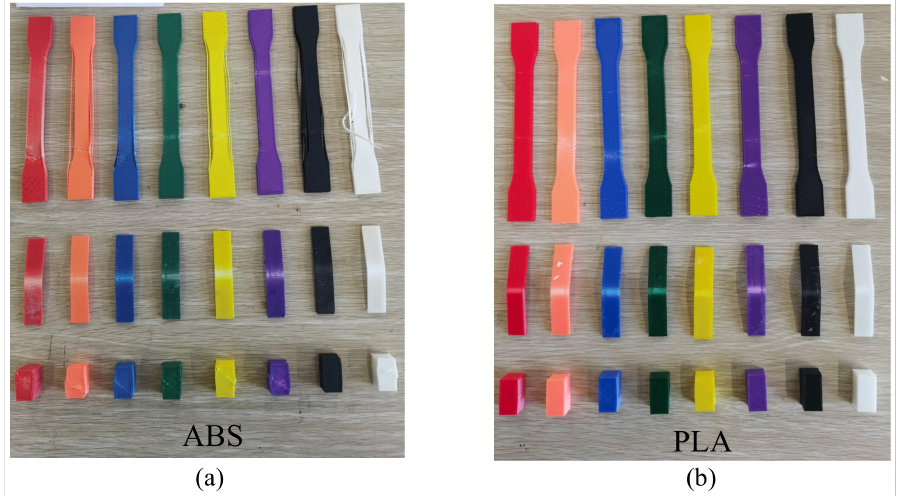
Figure 5. Part of broken specimens after testing: ( a ) ABS and ( b )